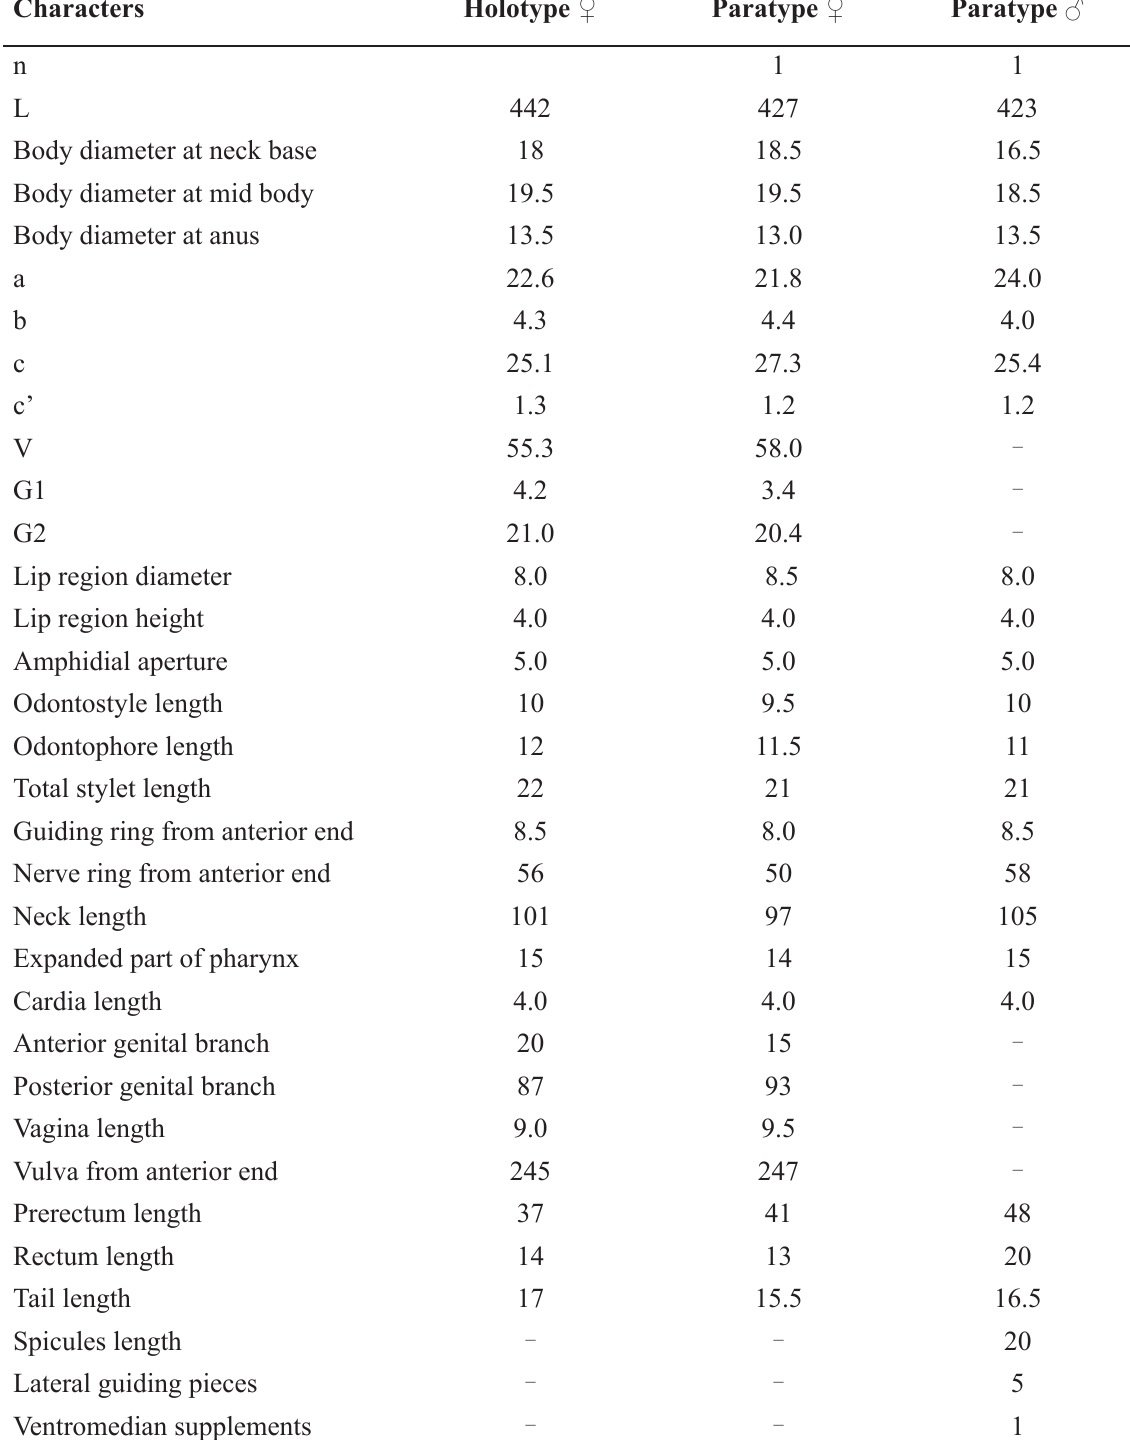
Table 7. Measurements of Basirotyleptus conicaudatus sp. nov. All measurements are in μm.